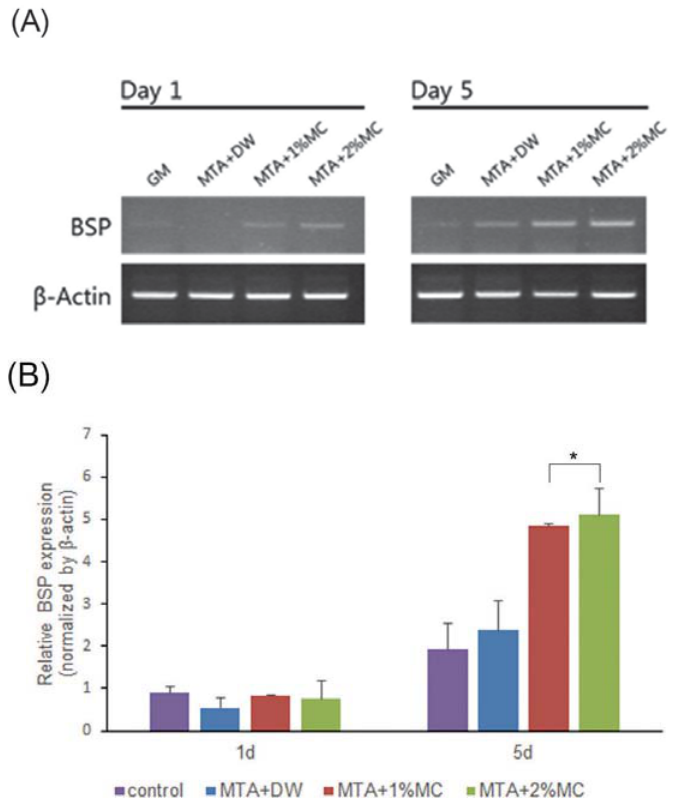
Figure 3- (cid:3)(cid:40)(cid:91)(cid:83)(cid:85)(cid:72)(cid:86)(cid:86)(cid:76)(cid:82)(cid:81)(cid:3)(cid:83)(cid:85)(cid:82)(cid:191)(cid:79)(cid:72)(cid:86)(cid:3)(cid:82)(cid:73)(cid:3)(cid:69)(cid:82)(cid:81)(cid:72)(cid:3)(cid:86)(cid:76)(cid:68)(cid:79)(cid:82)(cid:83)(cid:85)(cid:82)(cid:87)(cid:72)(cid:76)(cid:81)(cid:3)(cid:11)(cid:37)(cid:54)(cid:51)(cid:12)(cid:3)(cid:71)(cid:88)(cid:85)(cid:76)(cid:81)(cid:74)(cid:3)(cid:82)(cid:86)(cid:87)(cid:72)(cid:82)(cid:74)(cid:72)(cid:81)(cid:76)(cid:70)(cid:3)(cid:71)(cid:76)(cid:73)(cid:73)(cid:72)(cid:85)(cid:72)(cid:81)(cid:87)(cid:76)(cid:68)(cid:87)(cid:76)(cid:82)(cid:81)(cid:3)(cid:69)(cid:92)(cid:3)(cid:87)(cid:72)(cid:86)(cid:87)(cid:3)(cid:80)(cid:68)(cid:87)(cid:72)(cid:85)(cid:76)(cid:68)(cid:79)(cid:86)(cid:3)(cid:76)(cid:81)(cid:3)(cid:80)(cid:51)(cid:39)(cid:47)(cid:3)(cid:70)(cid:72)(cid:79)(cid:79)(cid:86)(cid:3)(cid:68)(cid:86)(cid:86)(cid:68)(cid:92)(cid:72)(cid:71)(cid:3)(cid:89)(cid:76)(cid:68)(cid:3)(cid:53)(cid:55)(cid:16) PCR and quantitative real-time PCR. (A) RT-PCR results. (B) The relative expression of BSP genes normalized against a